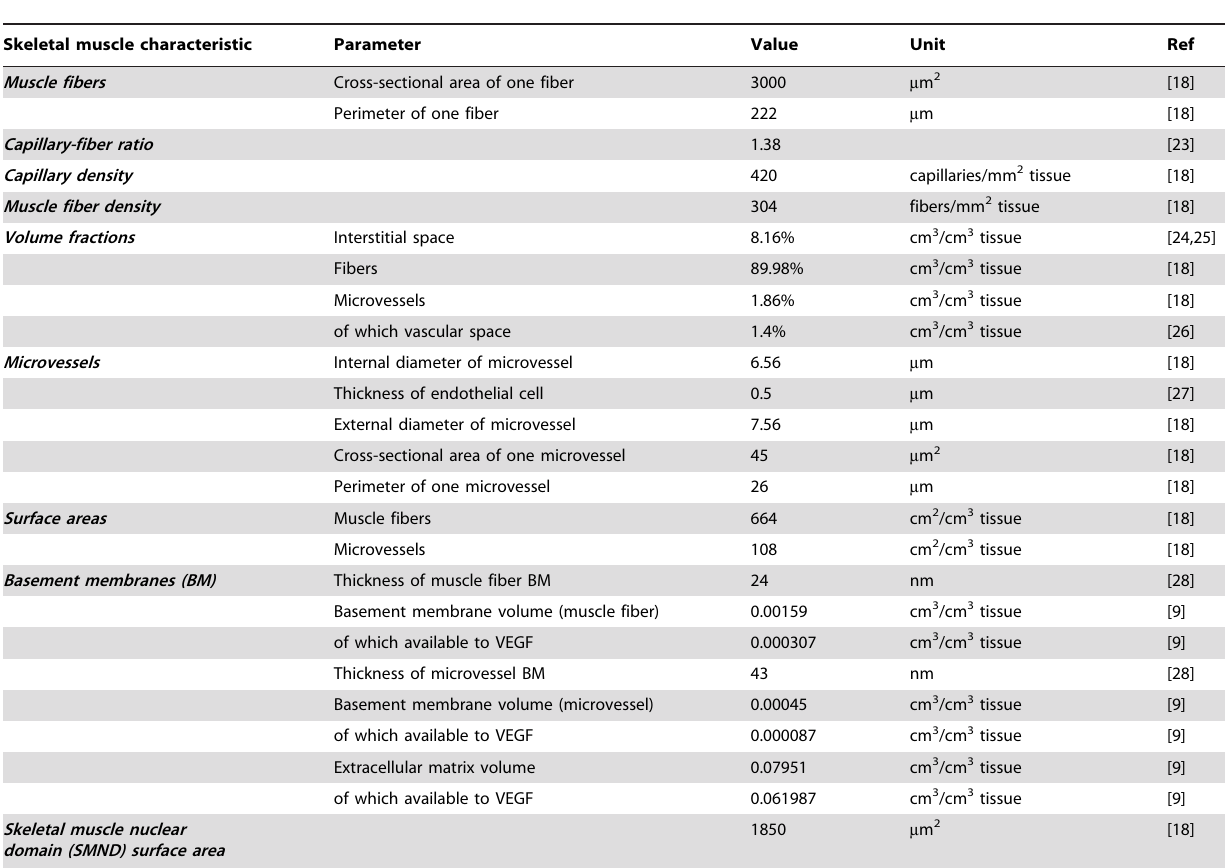
Skeletal muscle